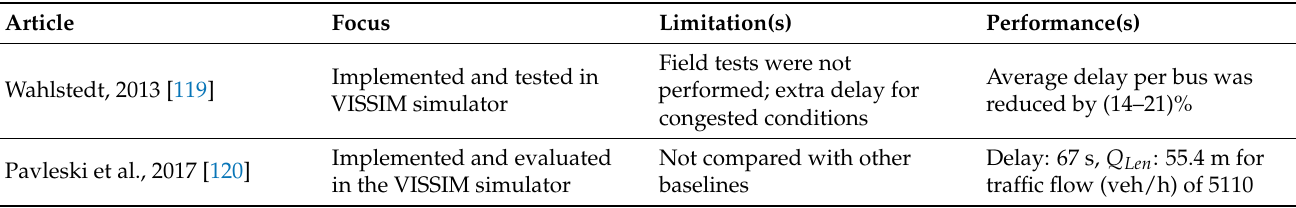
Table 20. Some reference works using